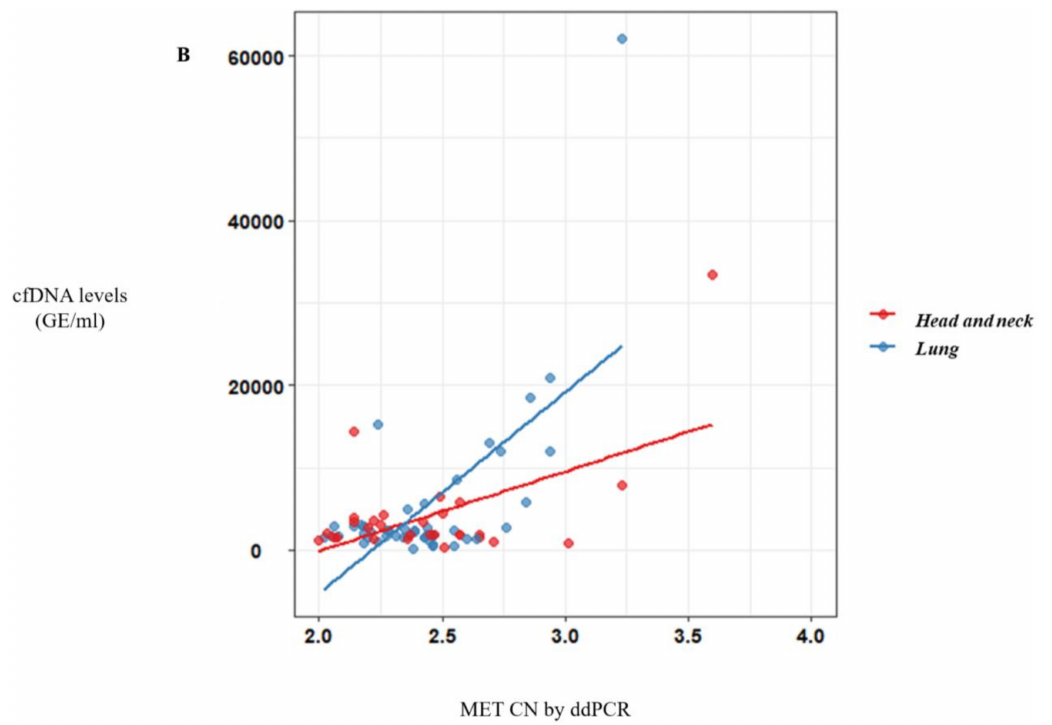
Figure 2. MET CN analysis in circulating free DNA (cfDNA) from metastatic cancer patients. ( A ) Correlation between cfDNA levels and plasma MET CN in all metastatic cancer patients ( n = 140); ( B ) Correlation between cfDNA levels and plasma MET CN in lung and head and neck cancer patients ( n =